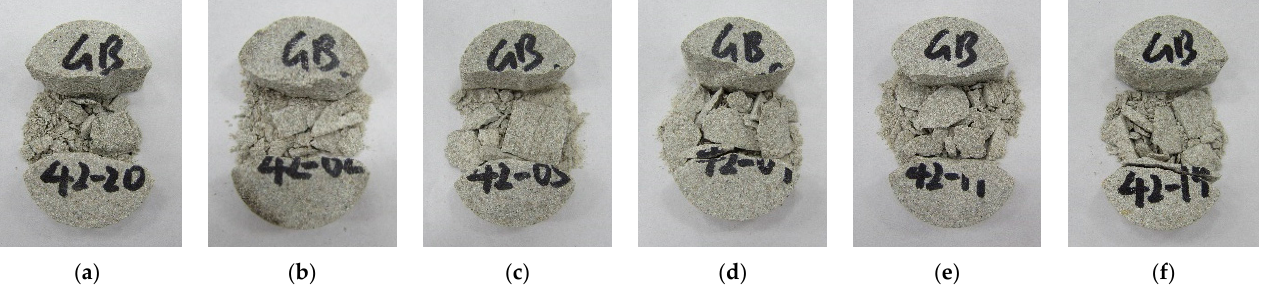
Figure 14. Dynamic tensile damage forms of sandstone with different corrosion times. ( a ) 0 d ( b ) 1 d ( c ) 3 d ( d ) 7 d ( e ) 14 d ( f ) 28 d. ( c ) 3 d ( d ) 7 d ( e ) 14 d ( f ) 28